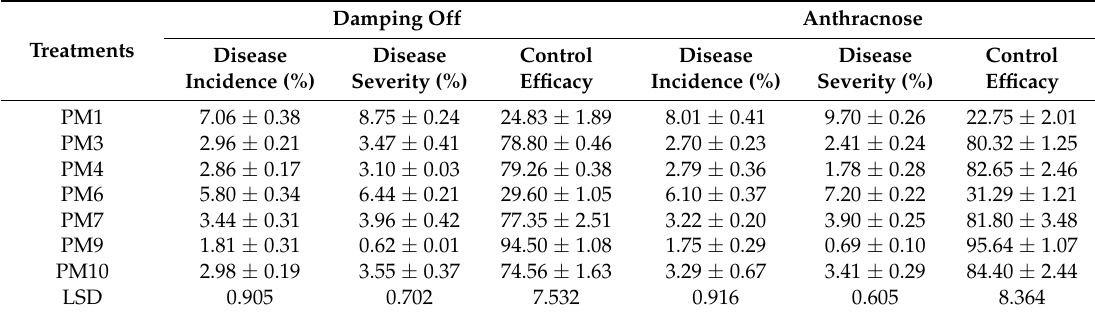
Table 1. Efficacy of PGPR’s consortium to control damping off and anthracnose in capsicum under field conditions.